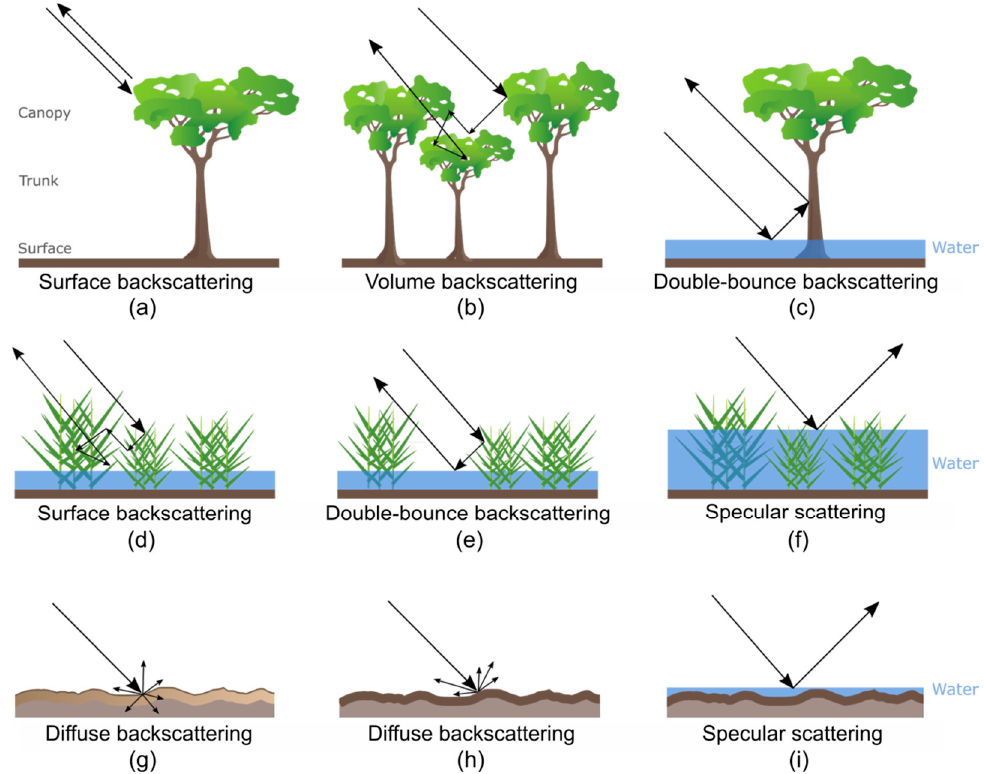
Figure 4. Radar backscattering mechanisms for forest, wetland and soil surfaces. ( a , b , g , h ): Non-flooded condition; signal scattering in the crown and on the ground. ( c – f , i ): submerged wetland / open water; strong double-bounce reflection between the tree trunks and the water surface. ( g – i ): Ground surface in wet ( g ), dry ( h ) and flooded conditions ( i ). Partly modified according to Lu and Kwoun [34].